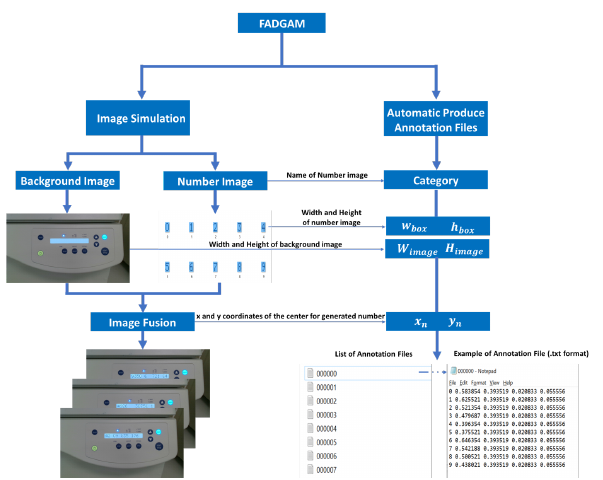
Figure 3. The flow chart of